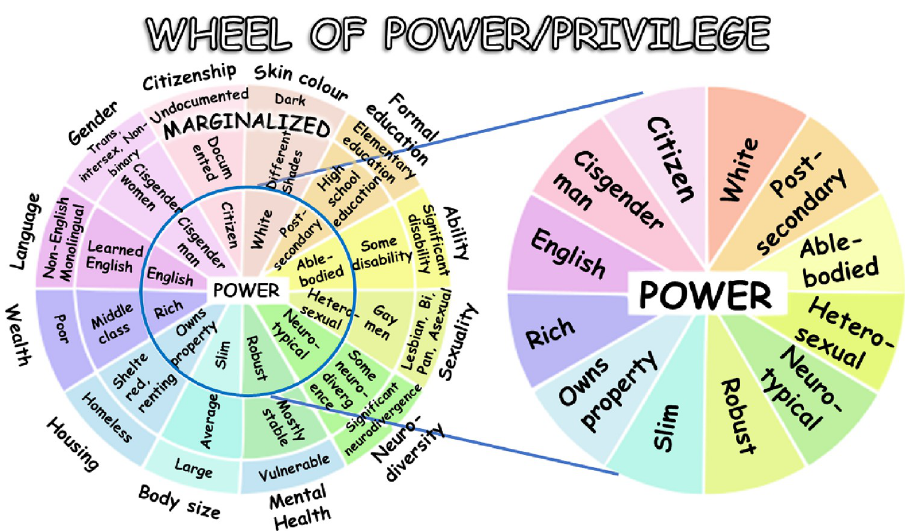
Fig 1. Power and privilege model of intersectionality